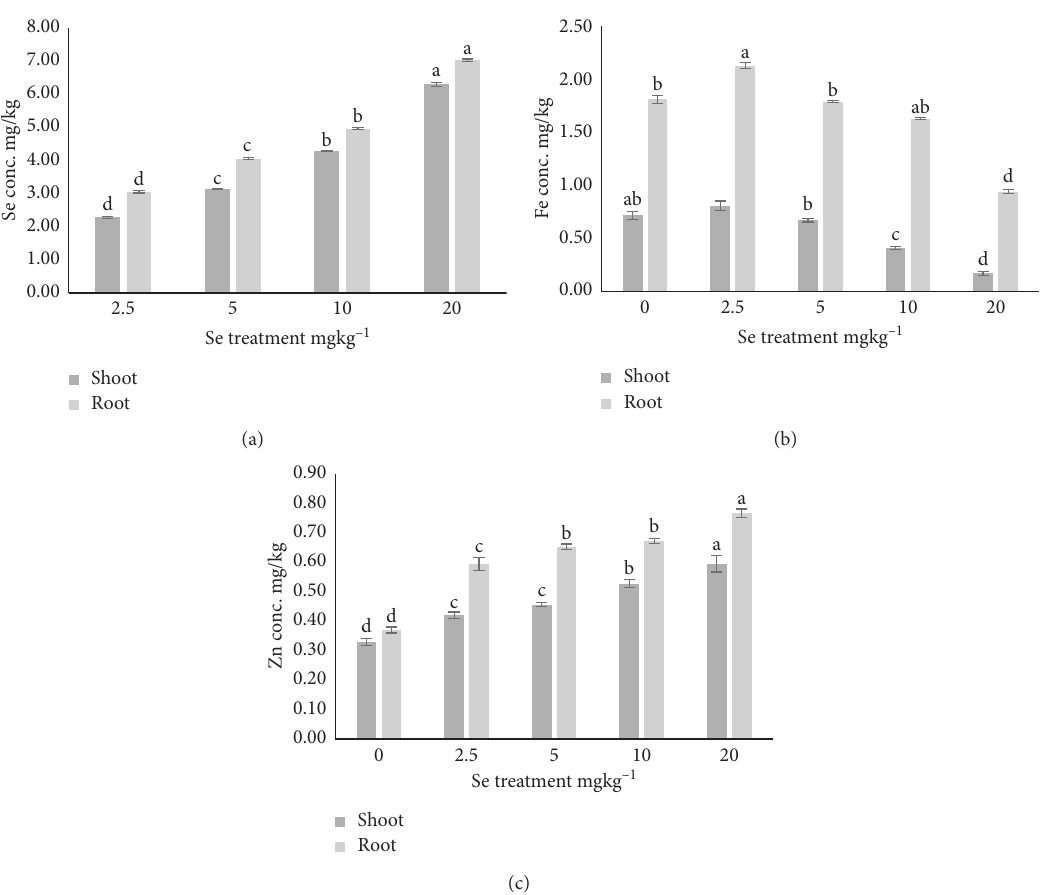
Figure 2: Effect of different doses of Se application on (a) selenium (Se), (b) iron (Fe), and (c) zinc (Zn) concentration in maize shoot and root. Error bars represent the SE for the mean of three replications.